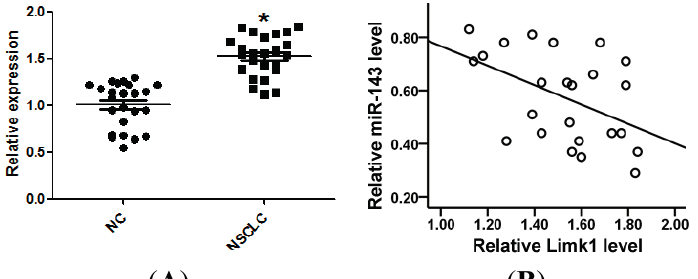
Figure 6. miR-143 is negatively correlated with Limk1 in NSCLC tissues. ( A ) The expression of Limk1 in 24 pairs of NSCLC tissues and the matched NC was measured by qRT-PCR; and ( B ) Limk1 mRNA level was inversely correlated with miR-143 level in NSCLC tissues (Spearman’s correlation analysis, r = − 0.503, p = 0.012). * p < 0.05 compared with